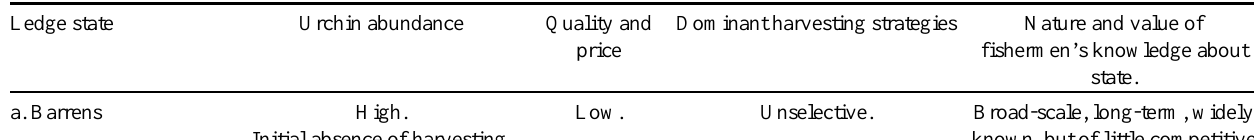
Table 1 . Ledge states and relevant characteristics: summary. Ledge state Urchin abundance Quality and price